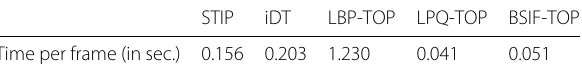
Table 6 Computational cost (detection+description) of various feature